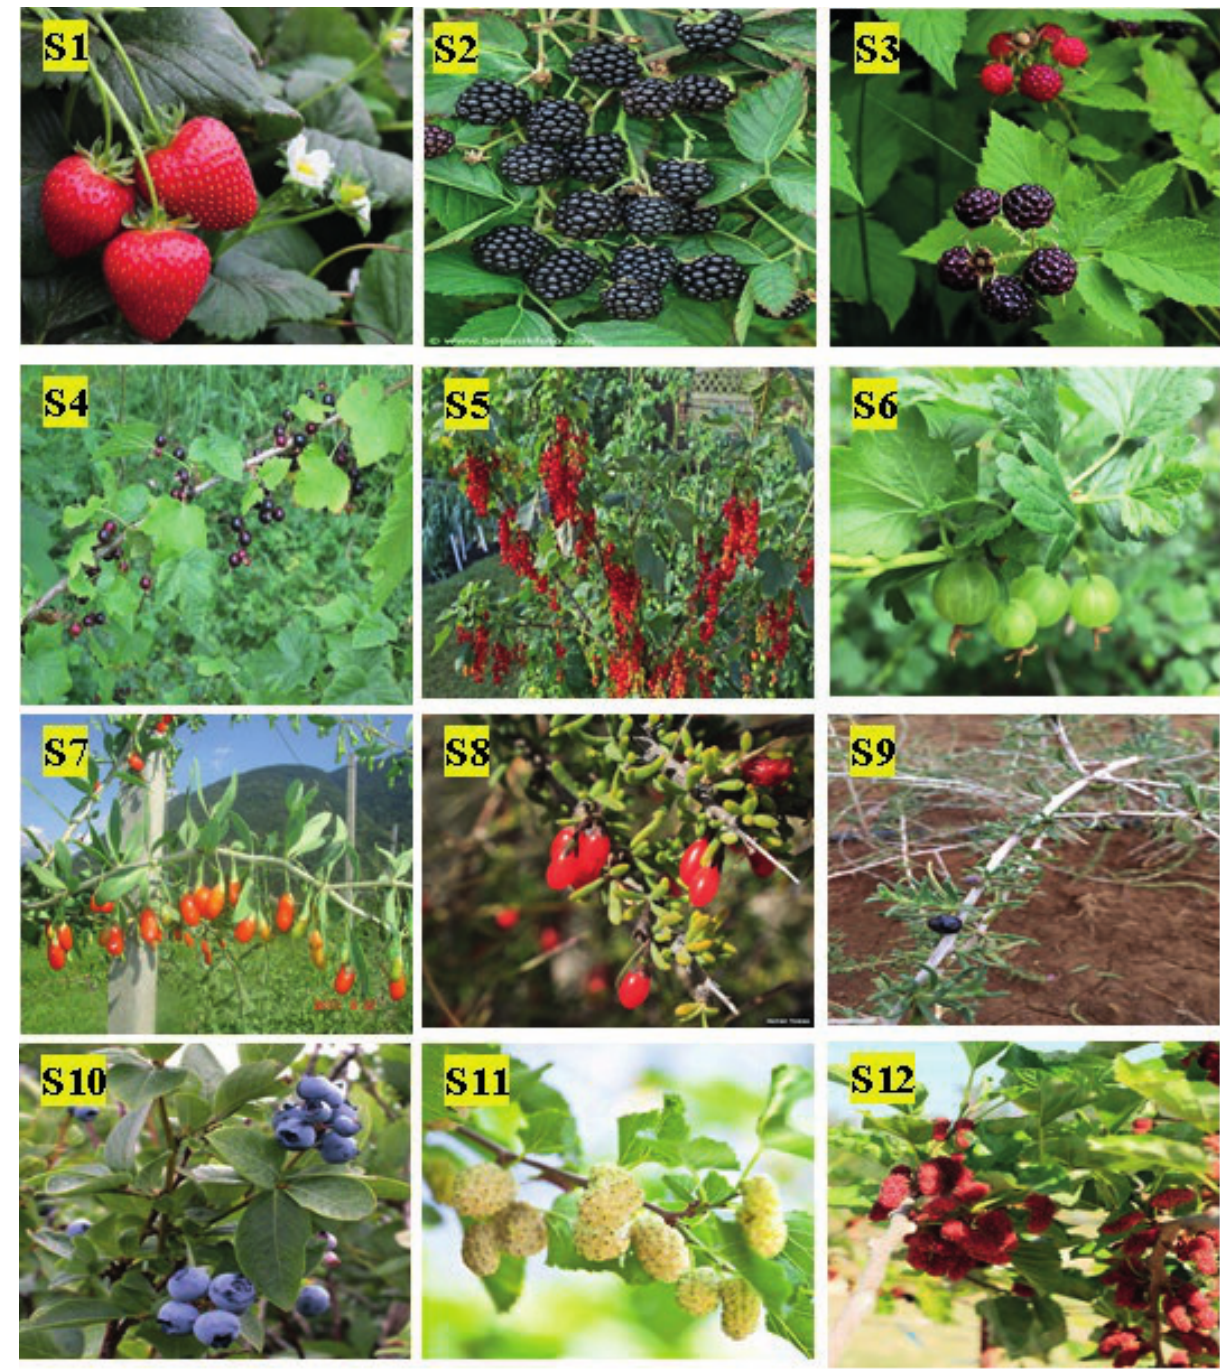
Figure 1. The picture of berry species that studied in this